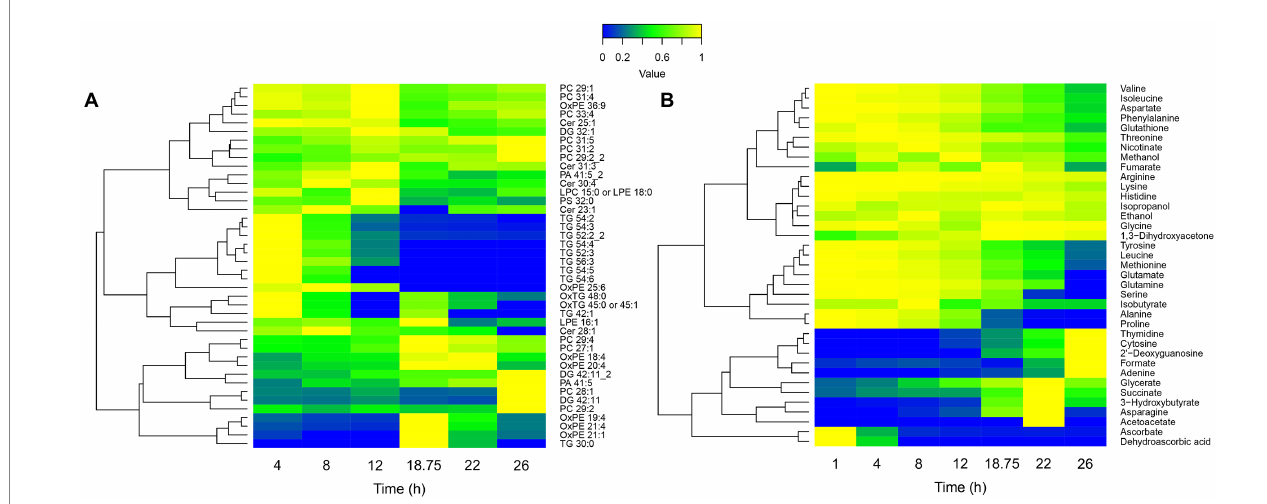
FIGURE 5 Lipidomic (A) and extracellular metabolomic (B) longitudinal data heatmaps of B . pertussis culture. Lipid intensities and metabolite concentrations are represented from 0 (blue) to 1 (yellow), 1 representing the maximum intensity/concentration of every feature. Features are clustered according to their trajectory similarities throughout the culture. Cer, ceramide; DG, diglycerides; LPC, lysophosphatidylcholine; LPE, lysophosphatidylethanolamine; Ox, oxydated; PA, phosphatidic acid; PC, phosphatidylcholine; PE, phosphatidylethanolamine; PG, phosphatidylglycerol; PS, phosphatidylserine; and TG,